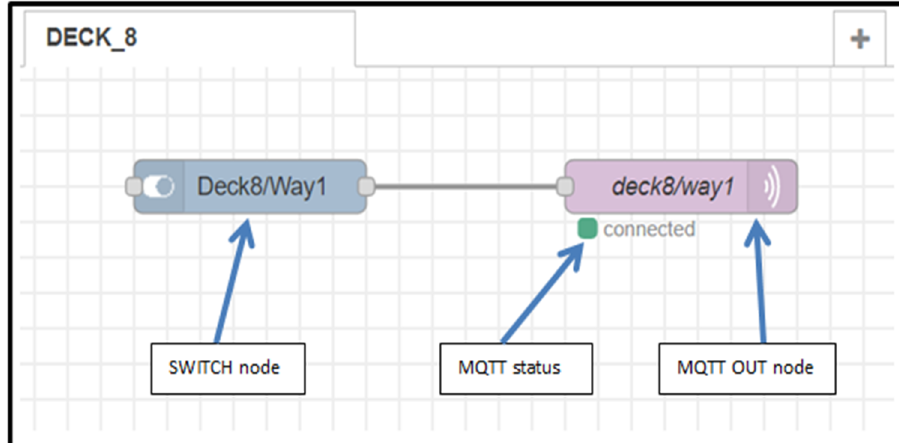
Figure 8. Experimental network architecture.